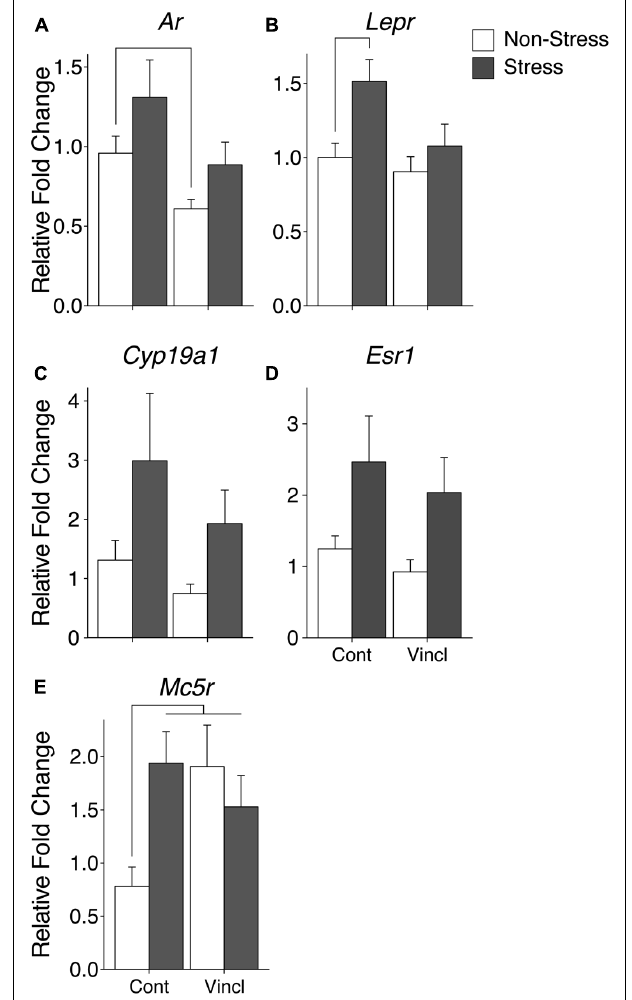
FIGURE 4 | Gene expression in the medial preoptic area (mPOA). Relative gene expression of (A) Steroid hormone receptor Ar , which shows a decrease of expression due to ancestral exposure. (B) Peptide receptor Lepr shows an effect of vinclozolin treatment, an effect driven by the large increase in expression in C-S animals. (C,D) Steroid synthesis enzyme Cyp19a1 (aromatase) and steroid hormone receptor Esr1 are both up-regulated by CRS. (E) Peptide receptor Mc5r shows an effect of vinclozolin exposure. Expression in C-S animals is also increased. Lines connecting group bars signify a significant post hoc pair-wise